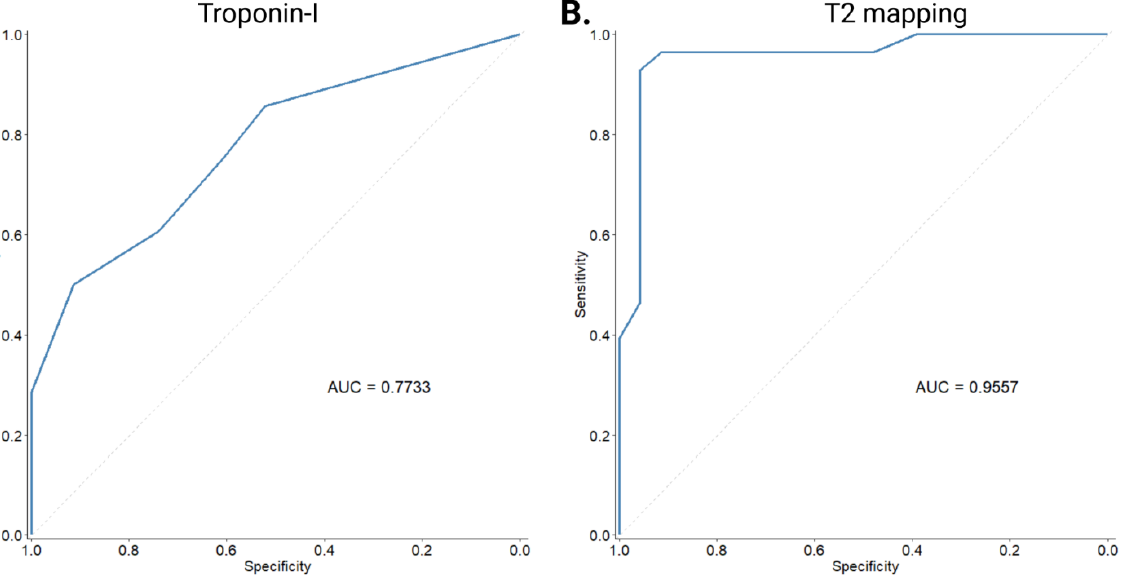
Figure 3. Receiver operating characteristic curve for discriminating between patients with genetic and inflammatory myopathies using troponin-I ( A ) and T2 mapping ( B ). AUC: area under the curve.